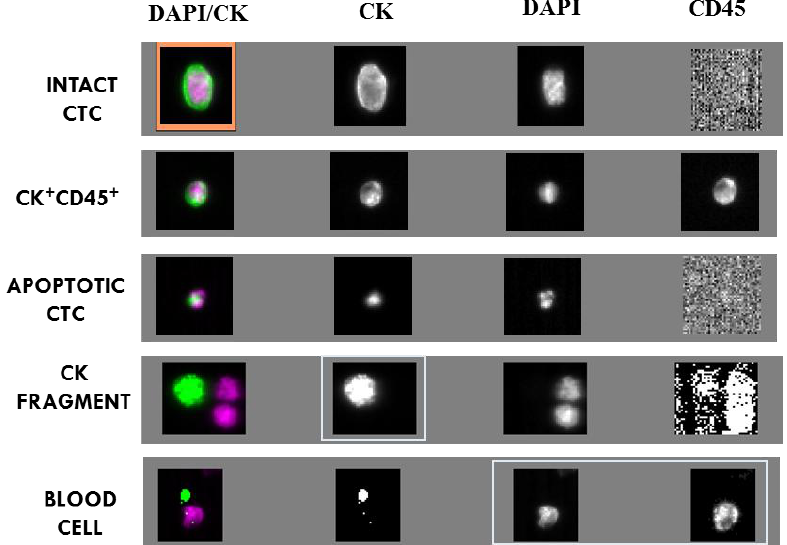
Figure 1. Images obtained after blood analysis of a NSCLC patient using CellSearch. We represented a morphological intact CTC (with an orange mark) round-oval, nucleated (DAPI + ) >4 µm, CD45 − and CK + ; a dual CK + and CD45 + cell; an apoptotic CTC with CK + , CD45 − and DAPI + staining but non standards of size and a CK fragment only with CK + staining and a blood cell CD45 + , CK − and DAPI +